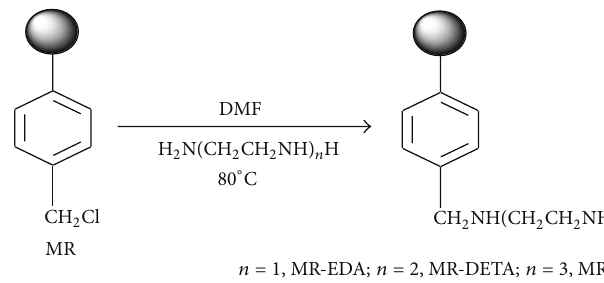
Figure 1: Proposed synthesis of MR-EDA, MR-DETA, and MR-TETA